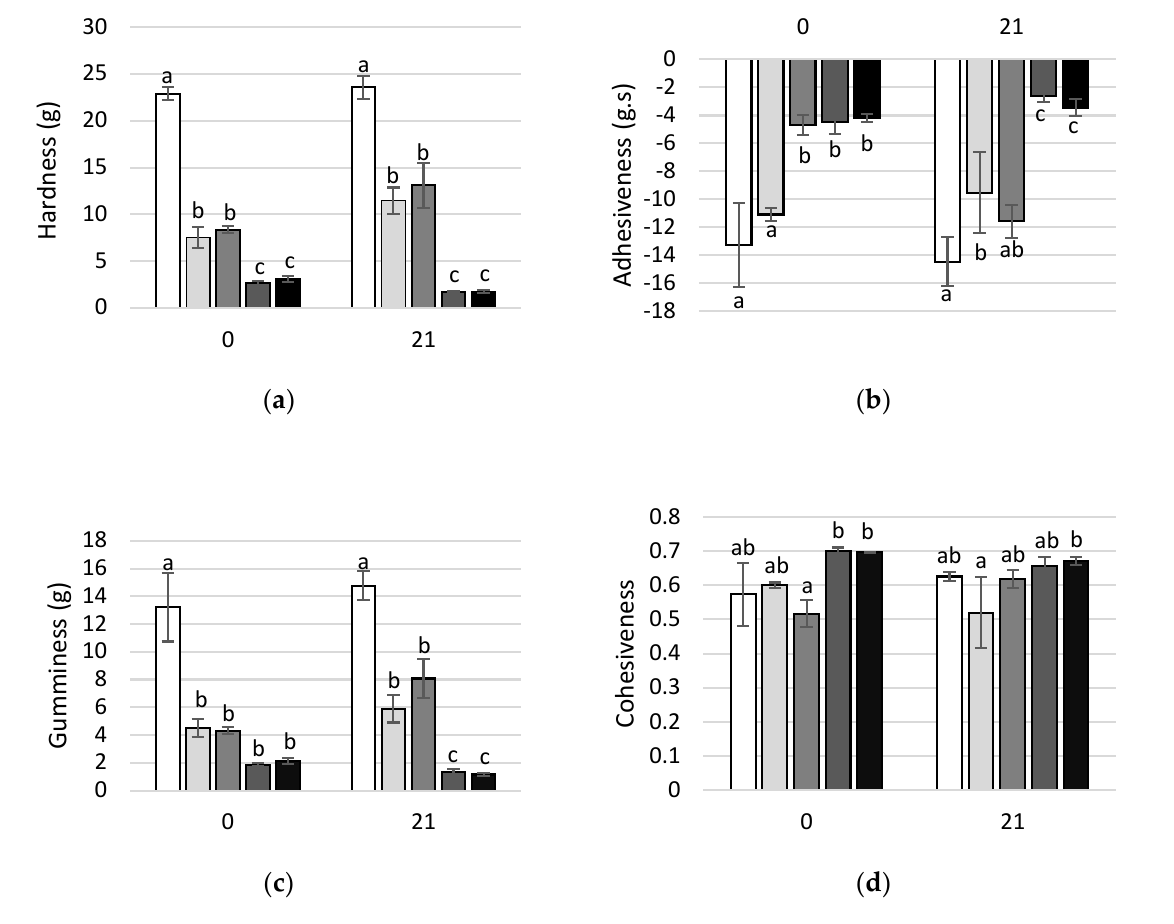
Figure 3. Textural attributes of whey cheese matrices at beginning and end of storage. Parameters: hardness ( a ); adhesiveness ( b ); gumminess ( c ); cohesiveness ( d ). WC (non-inoculated); WCP (control); WCPS (with SCWP); WCPST (with SCWP and thyme EO); WCPSTC (with SCWP, thyme EO and sodium citrate). a,b,c Means within the same day of storage labeled with different superscripts differ significantly ( p < 0.05).